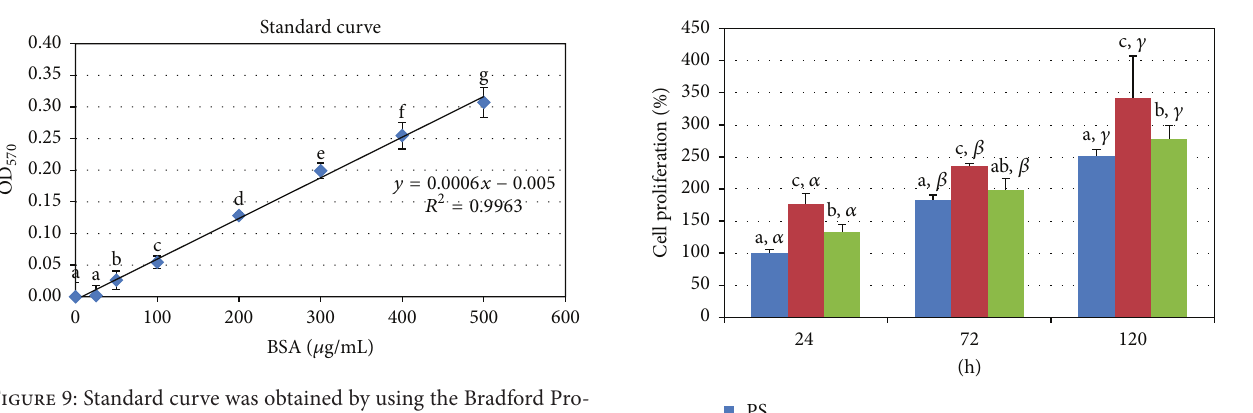
Figure 9: Standard curve was obtained by using the Bradford Pro- tein assay procedure. Statistical differences between each group are represented as the lowercase letters (a–g) ( 𝑝 ≤ 0.05 ).